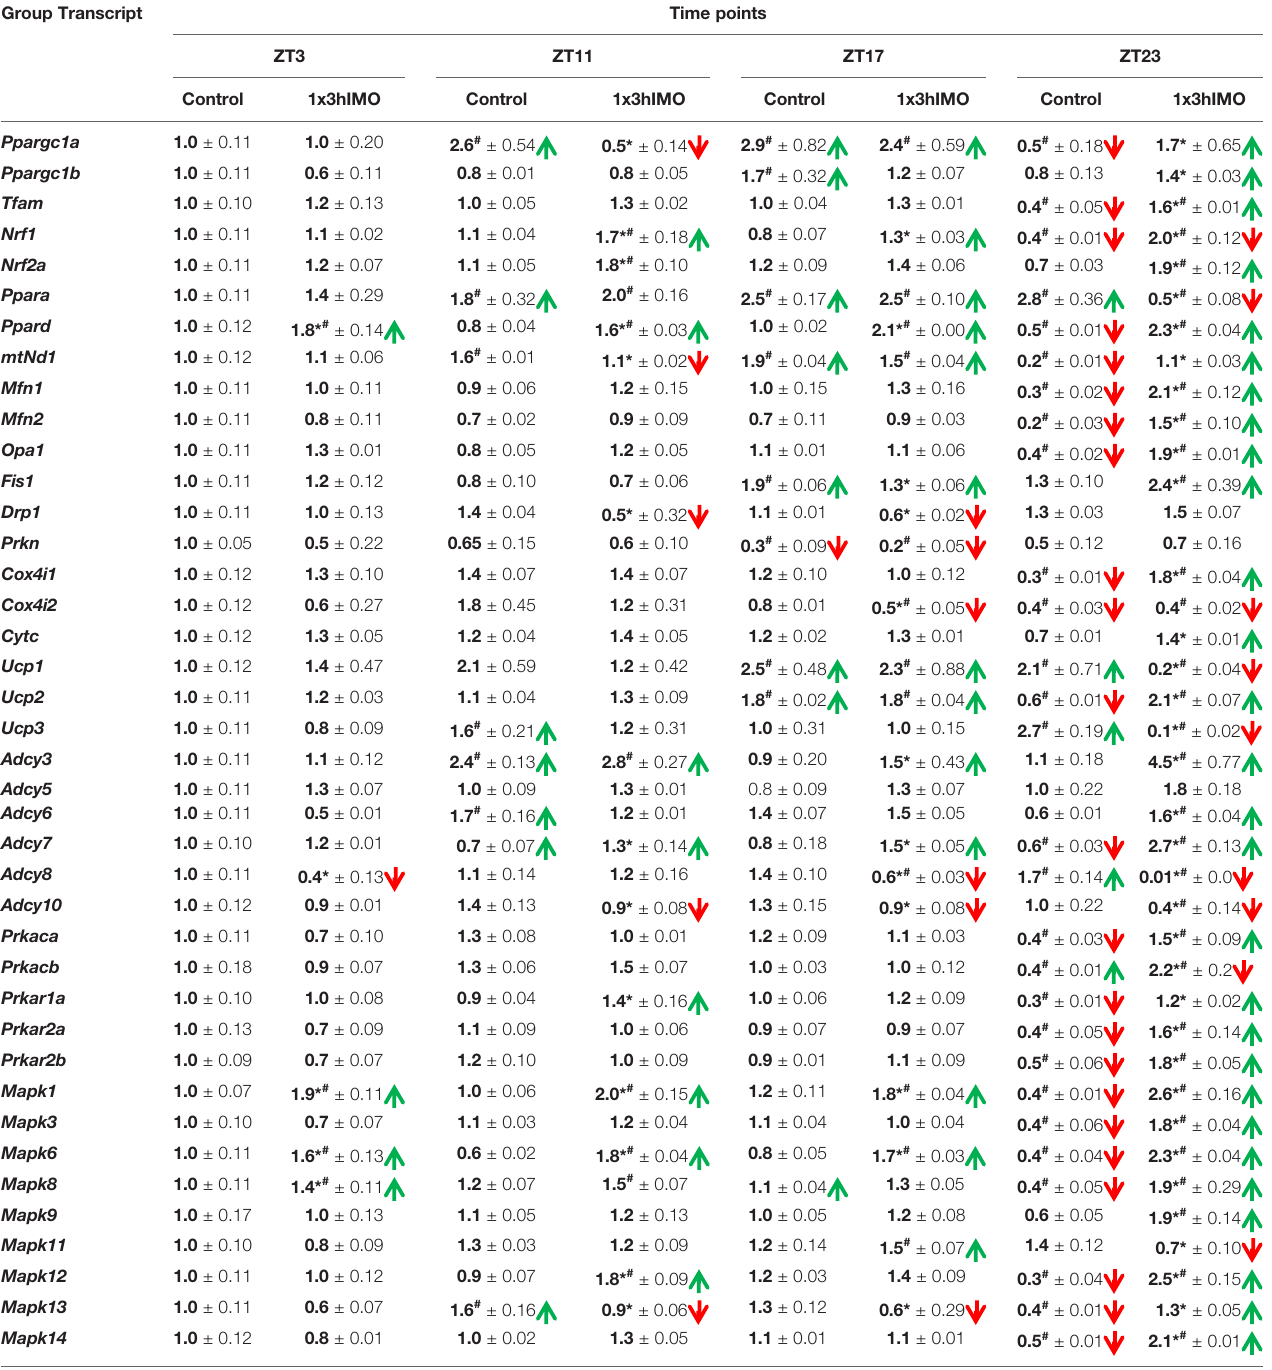
TABLE 1 | The transcriptional pro fi les of mitochondrial dynamics and functionality markers and signaling molecules regulating mitochondrial dynamics and functionality as well as spermatozoa number and functionality in spermatozoa of stressed adult rats. Group Transcript Time